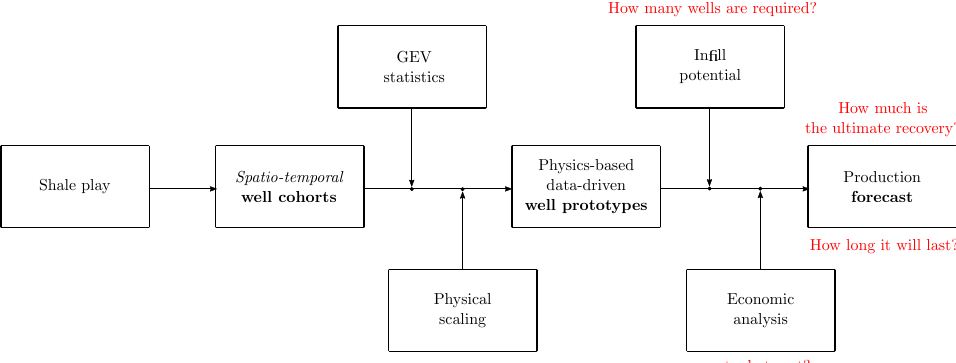
Figure 18. Methodology used to obtain economic tight oil/gas production forecasts in the Permian Basin (adapted from